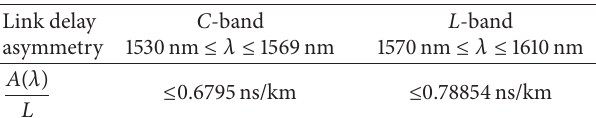
Table 1: Maximum fiber link delay asymmetry for the two extreme